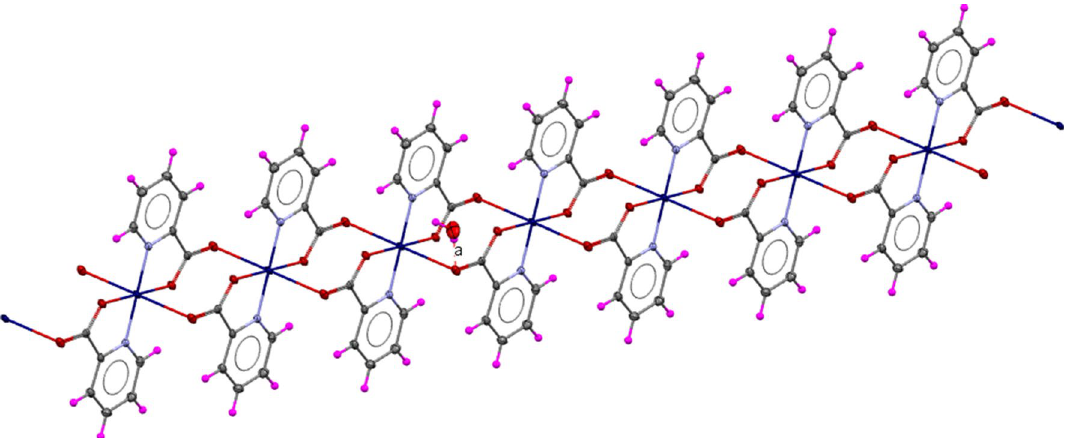
Fig. 4 Extended view of CP-1 showing 1D grid polymeric nature